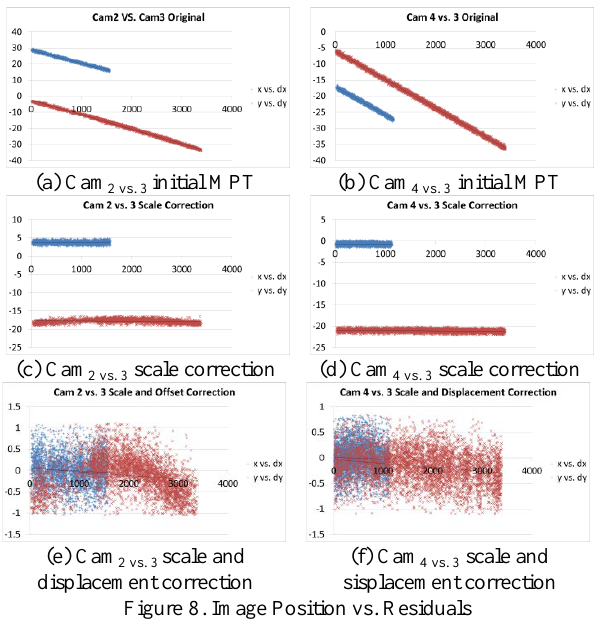
Figure 8. Image Position vs.